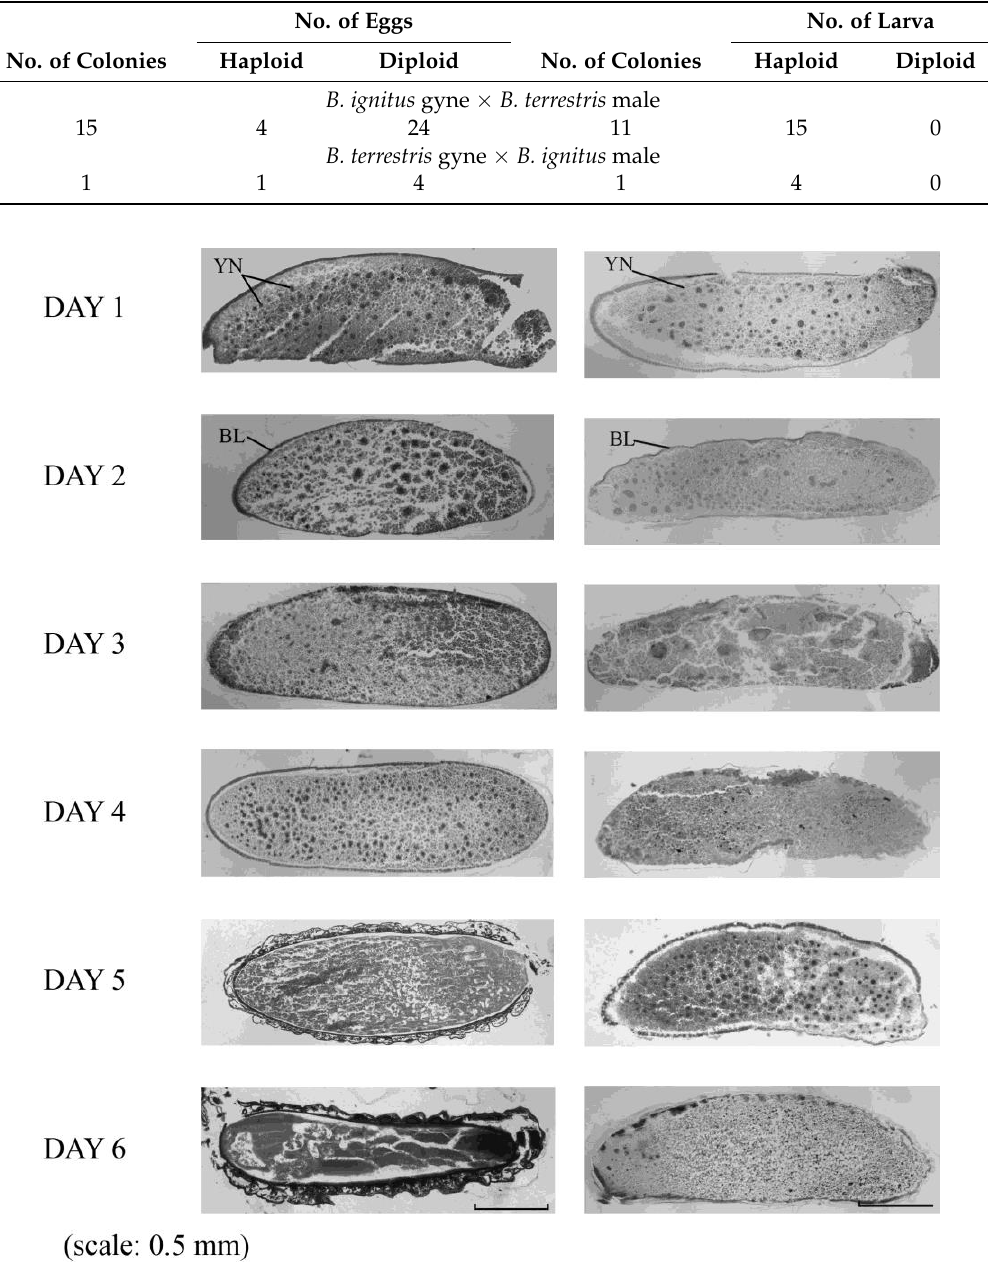
Figure 2. Serial sections of eggs 1 to 6 days after oviposition from interspecific mating between a Bombus ignitus queen and a B . terrestris male under laboratory conditions. The left column is a series of pictures of intraspecific mating; the right column includes pictures of interspecific mating. YN, yolk nucleus; BL, blastoderm. Scale: 0.5 mm.